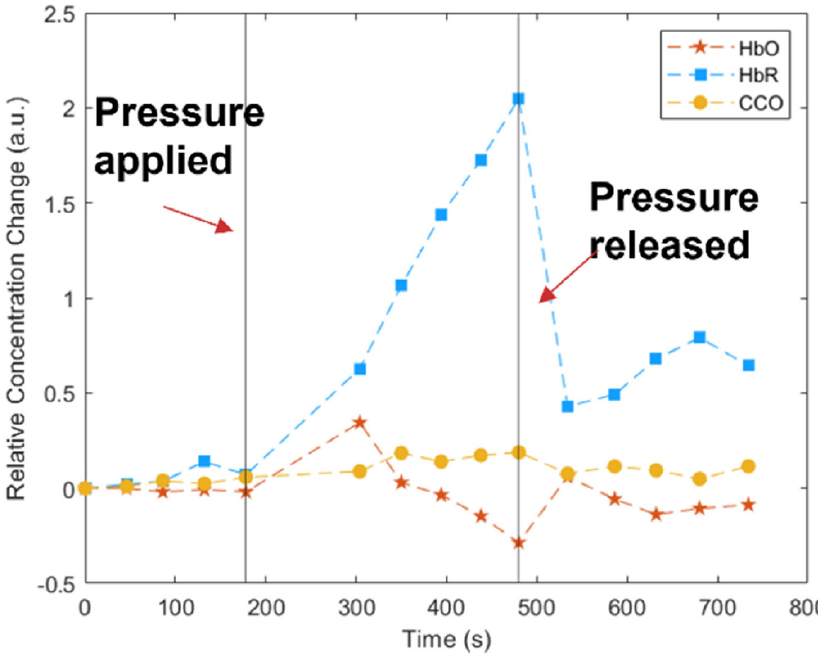
Figure 8. Measured changes in HbO, HbR, and the redox state of CCO during a blood pressure test.